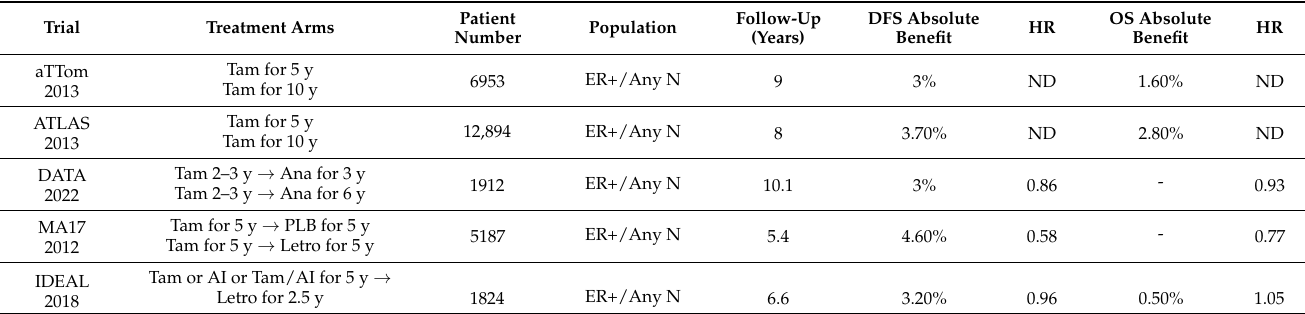
Table 1. Main extended ET trials’ features and